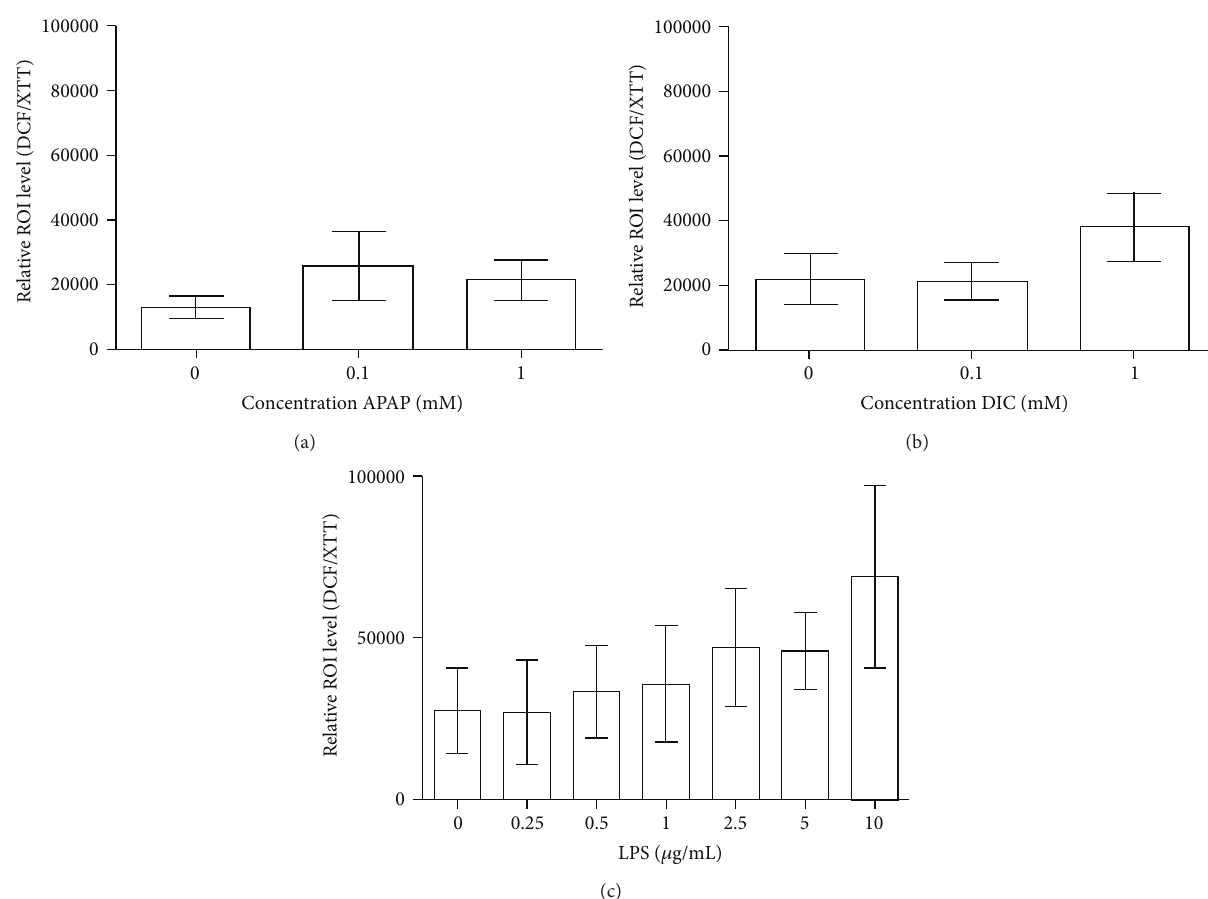
Figure 3: APAP-, DIC- or LPS-induced stimulation of KC . APAP (a), DIC (b), or LPS (c) in different concentrations were used for the stimulation of KC for 24 h. The intracellular ROI formation was investigated by the DCF assay. The detected ROI levels were normalized to the cell viability measured by means of the XTT assay. Data show means ± SEM. 𝑁